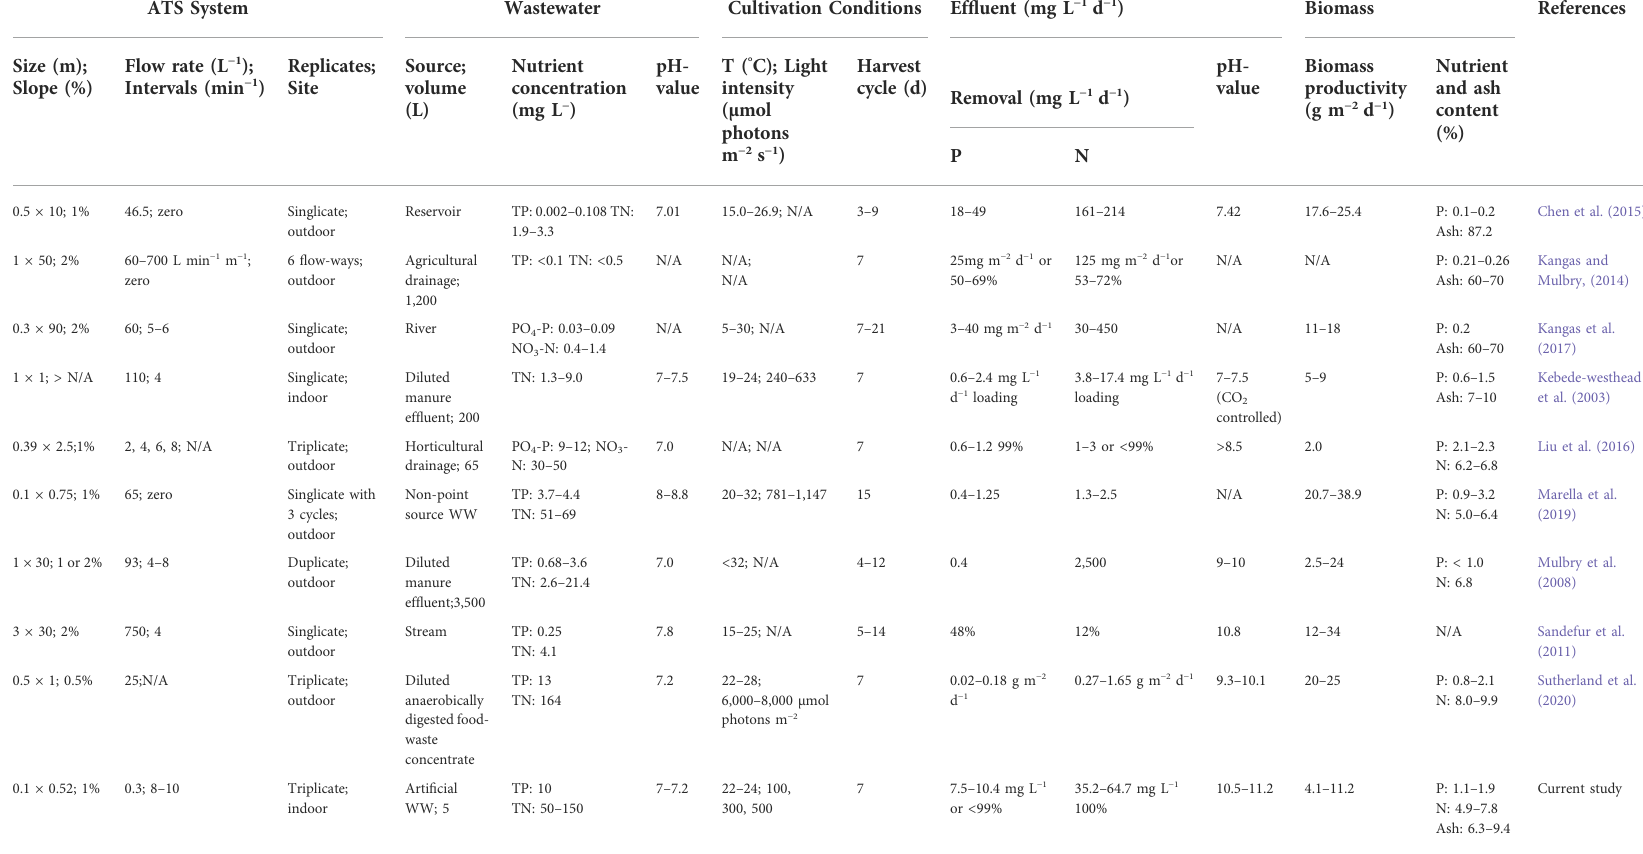
TABLE 1 The settings and performances of reviewed algal turf scrubber (ATS) systems. ATS